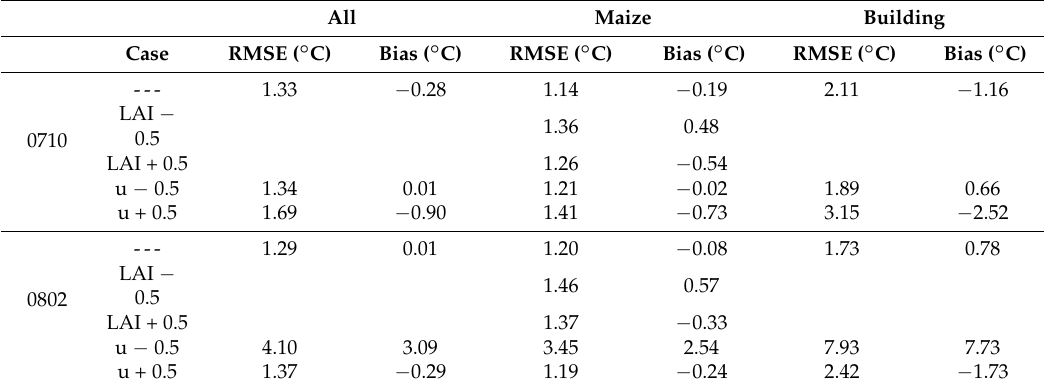
Table 3. Statistical information on the simulated BTs with different LAI and wind speed